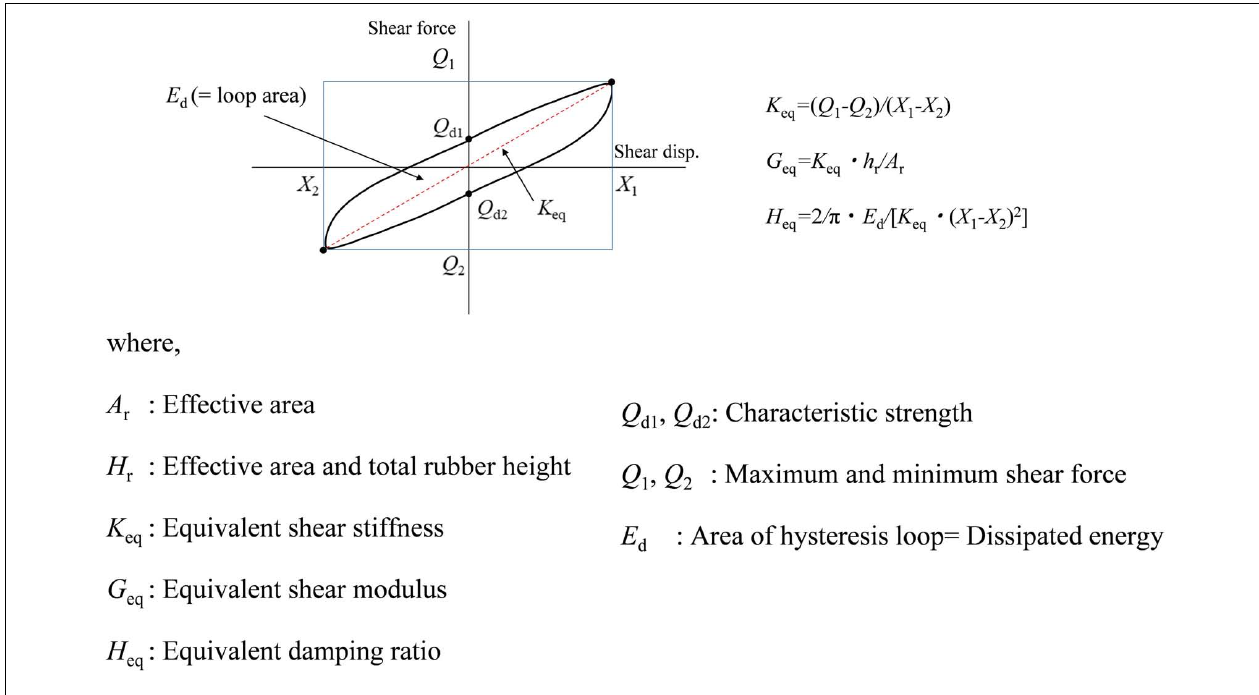
FIGURE 1 | Definition of shear properties of HDR.